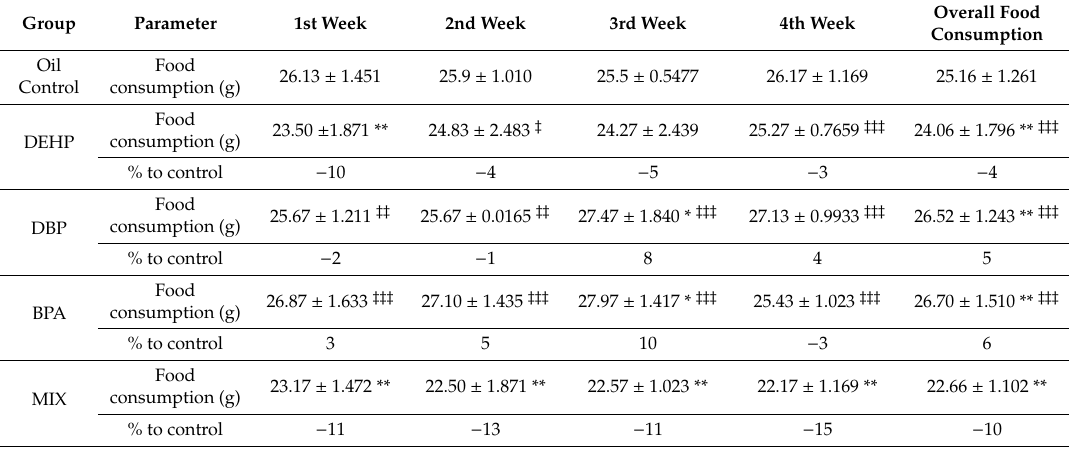
Table 2. Food consumption of rats orally exposed to DEHP, DBP, BPA, and their mixture (MIX) for 28